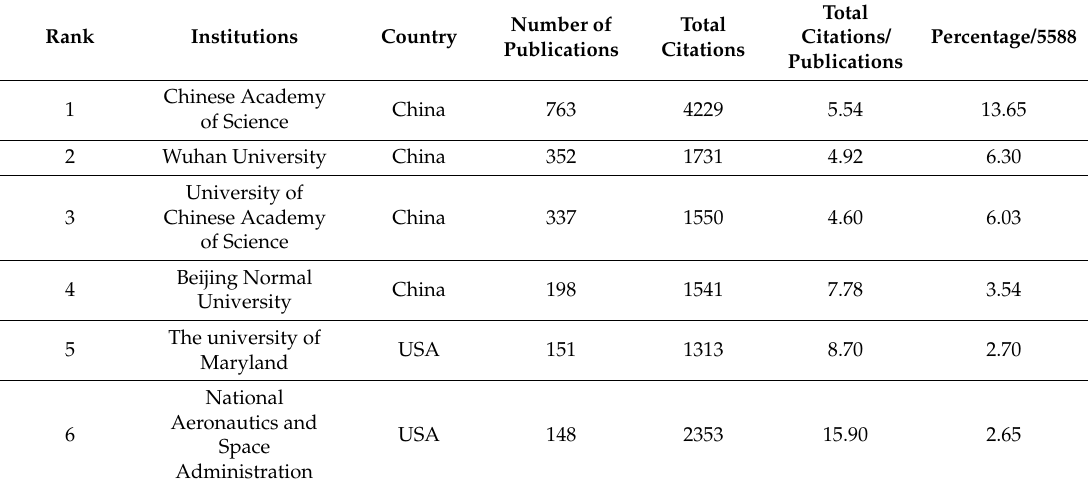
Table 8. Most productive institutions in Remote Sensing Open Access Journal (RS OAJ) (Top 50).